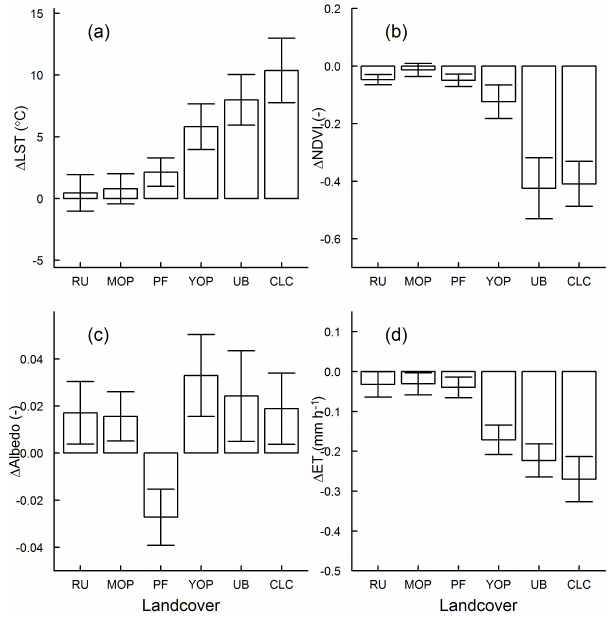
Figure 3. Average surface temperature (LST) and standard devia- tion (SD) of seven land cover types derived from a Landsat ther- mal image compared with the mean and SD of MODIS LST. The dashed line is the theoretical 1 : 1 line, and the solid lines are the linear model type 2 regression line (black) and the confidence lim- its of the regression line (red). The Landsat and MODIS images were acquired on 19 June 2013, at 10:13 and 10:30 local time, re- spectively. Landsat pixels (30m) were resampled to MODIS pixel resolution (926m) to make a pixel-to-pixel comparison between the two sources possible.